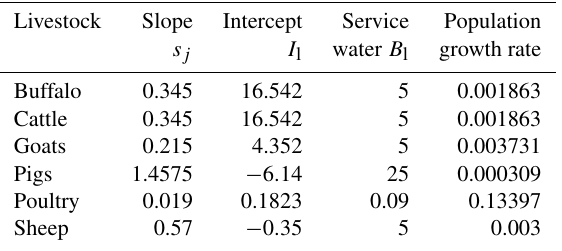
Table 2. Default livestock parameters for the livestock water use